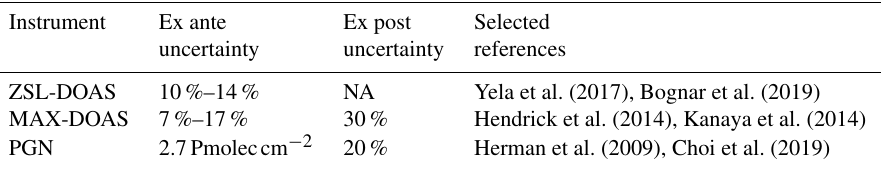
Table 2. Estimated uncertainties for the different types of ground-based measurements used in this work. Ex ante refers to uncertainties provided with the data, based on a propagation of raw measurement uncertainties and on sensitivity analyses. Ex post refers to uncertainty estimates derived by comparison with other (independent) measurements, which inevitably also contain some representativeness uncertain- ties. More detail is provided in the dedicated subsections of Sect. 2. Instrument Ex ante Ex post Selected uncertainty uncertainty ZSL-DOAS 10%–14% NA Yela et al. (2017), Bognar et al. (2019) MAX-DOAS 7%–17% 30% Hendrick et al. (2014), Kanaya et al. (2014) PGN 2.7Pmoleccm − 2 20% Herman et al. (2009), Choi et al.